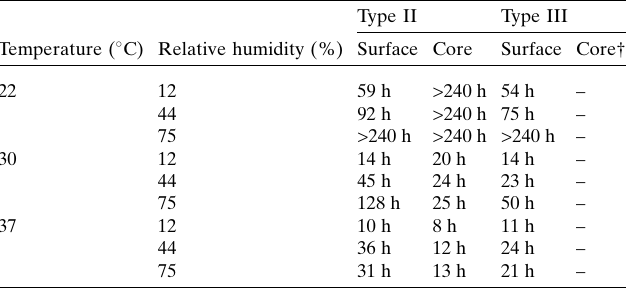
Table 1 Comparison of the time of onset phase transition for type-II and type-III crystals in